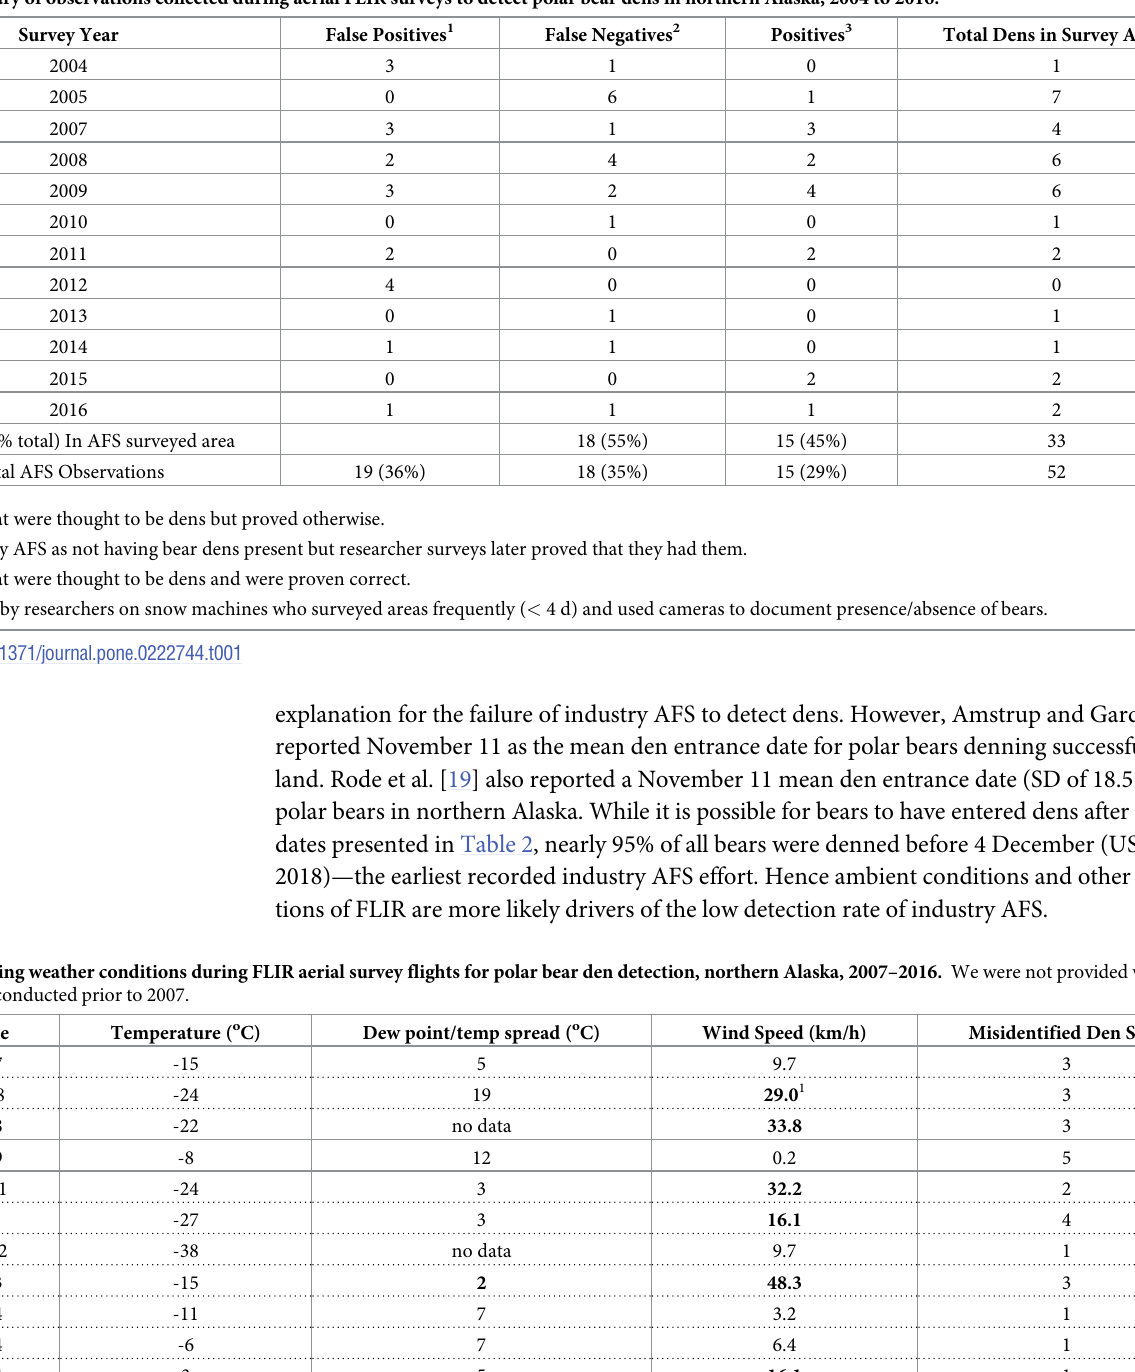
Table 1. Summary of observations collected during aerial FLIR surveys to detect polar bear dens in northern Alaska, 2004 to 2016.